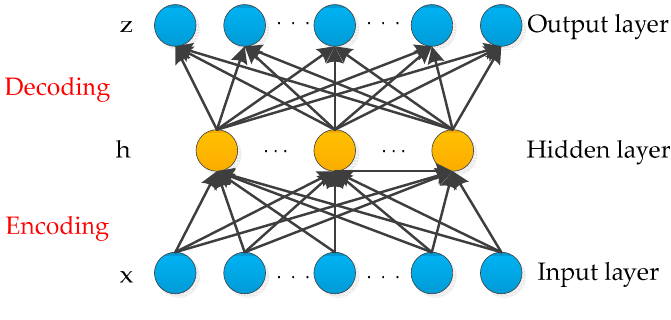
Figure 1. Figure 1. Auto-encoder.